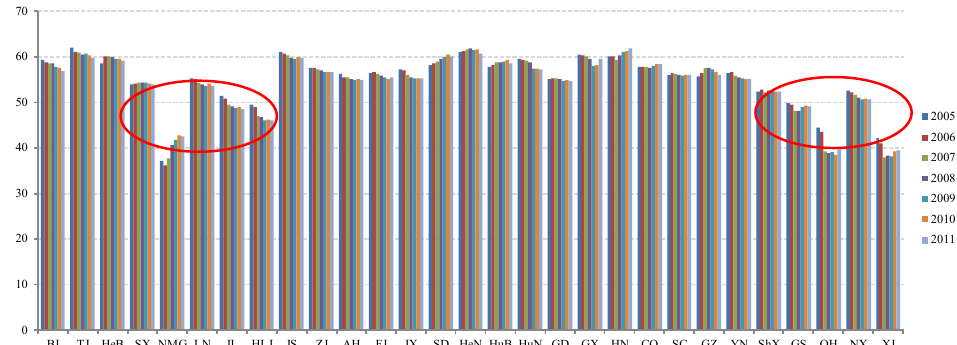
Figure 3. Trends of regional energy poverty scores from 2005 to 2011.